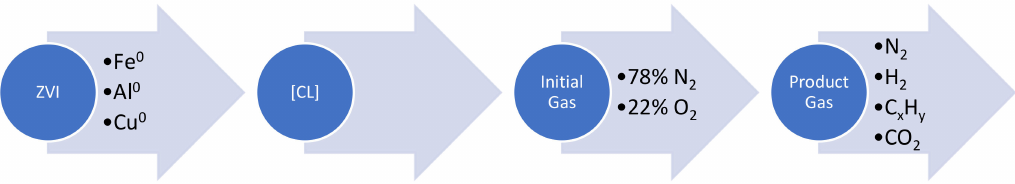
Figure 6. Conceptual process flow within the ZVI retort over 24